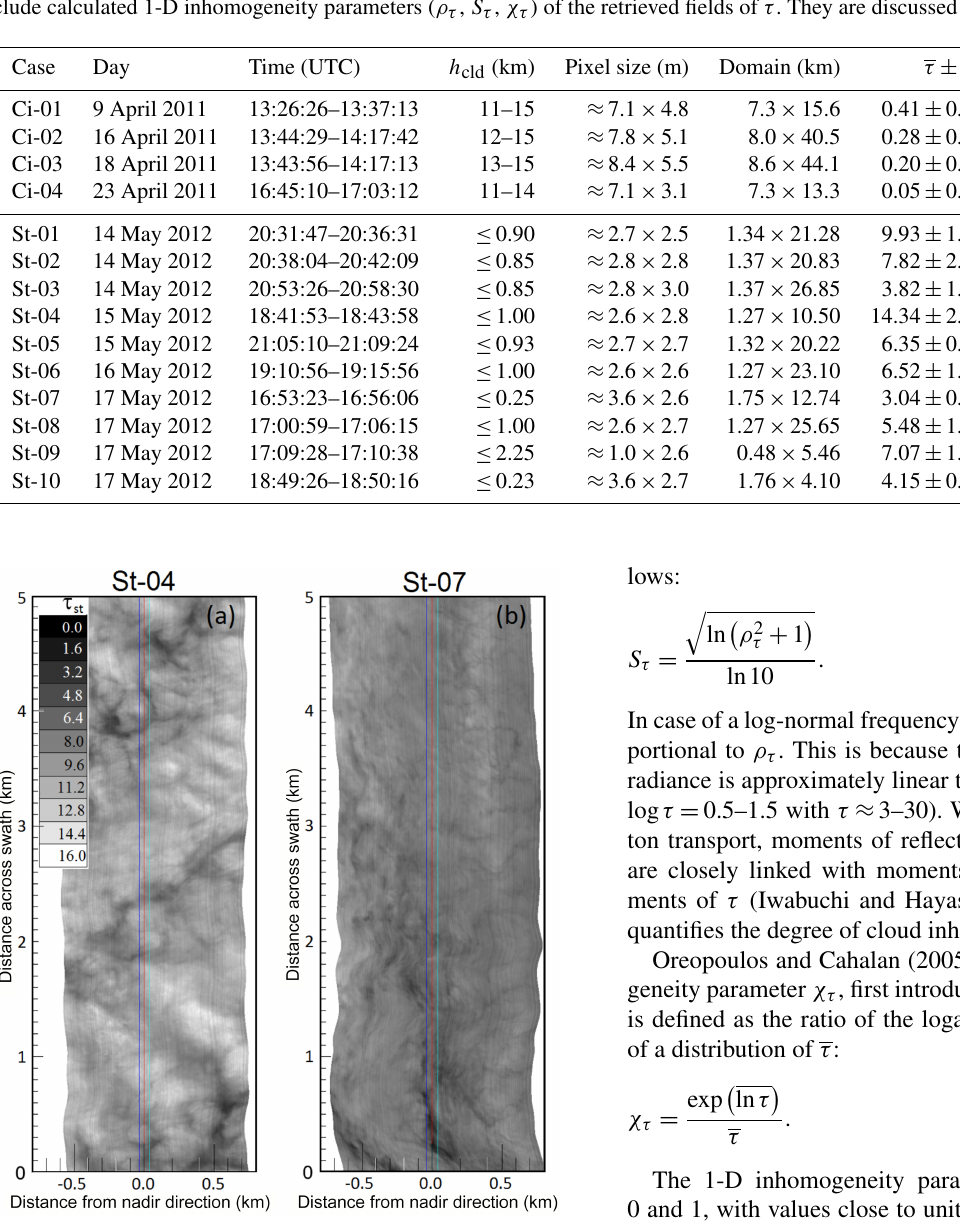
Table 1. Label, measurement period (day and time of day in UTC), cloud top altitude, pixel size (width, length), domain size (swath, length), and average and standard deviation ( τ ± σ τ ) of the retrieved fields of τ ci and τ st from ground-based measured CARRIBA (Ci-01 to Ci-04) and airborne measured VERDI (St-01 to St-10) cases. The flight altitude for each VERDI case was at 2920m. The right three columns include calculated 1-D inhomogeneity parameters ( ρ τ , S τ , χ τ ) of the retrieved fields of τ . They are discussed in Sect. 3.